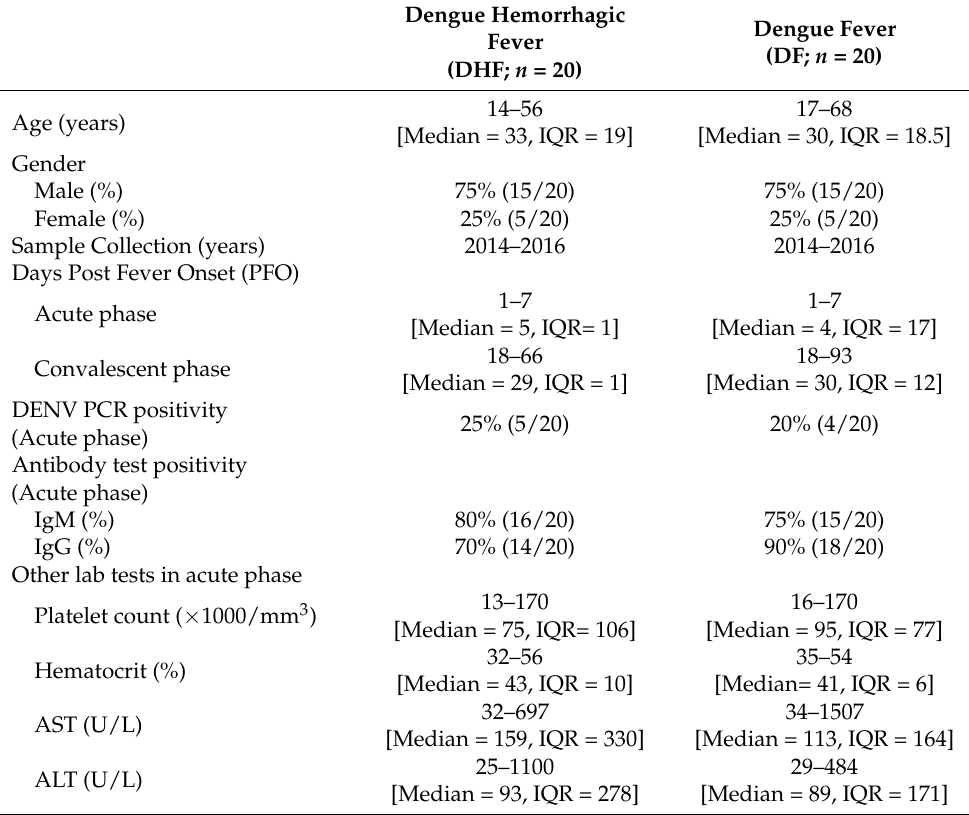
Table 1. General characteristics of hospitalized cohort with dengue